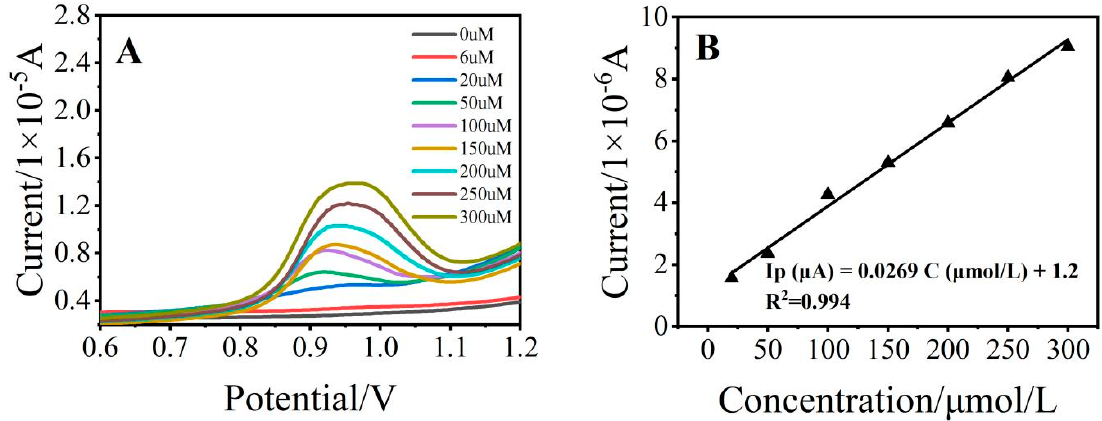
Figure 5. ( A ) Differential pulse diagram of the glassy carbon electrode for different concentrations of SDZ standard solution; and ( B ) Linear relationship between different concentrations of SDZ and the oxidation current.